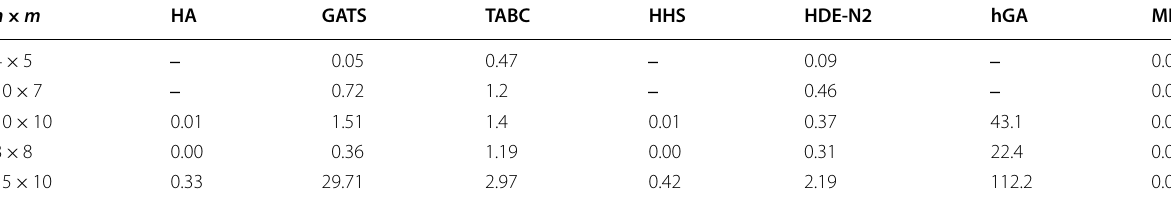
Table 2 CPU time comparison for instances in experiment 1